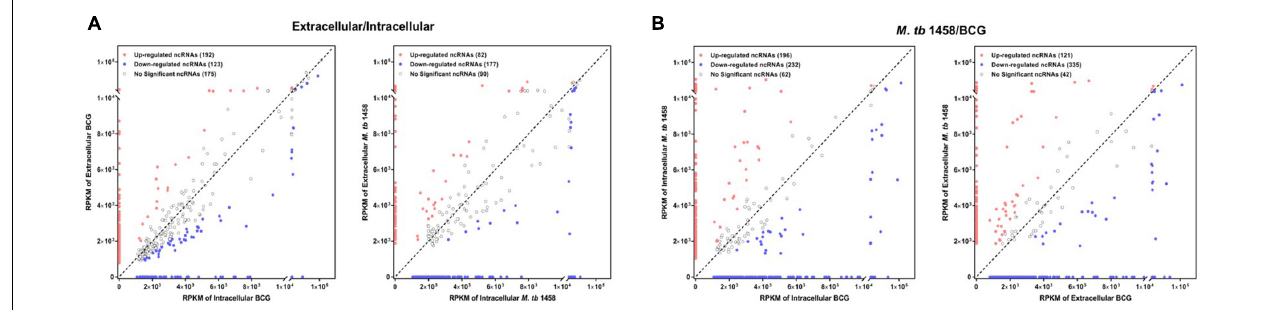
FIGURE 2 | RPKM distribution of ncRNAs: (A) Mycobacterium tuberculosis 1458/BCG RPKM distribution of ncRNAs between intracellular and extracellular bacteria (| FC| > 1.5). (B) RPKM distribution of ncRNAs between BCG and M. tb 1458 (| FC| > 1.5).